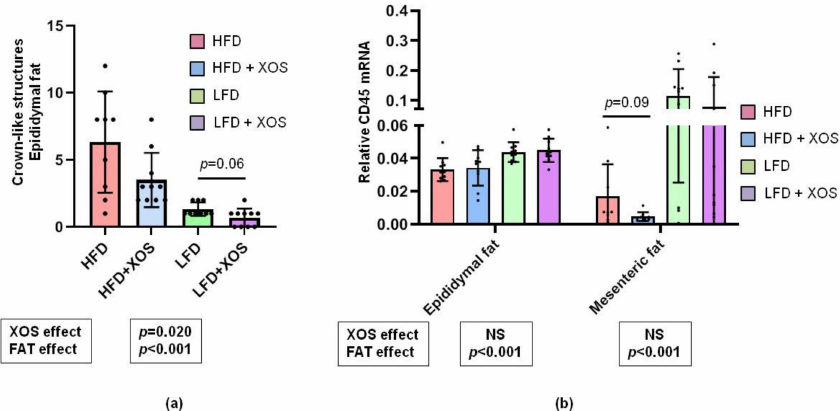
Figure 4. The effects of the diets on adipose tissue inflammation markers. ( a ) The graph shows the observed counts of CLSs in epididymal adipose tissue as determined by histopathological scoring. N = 10/group. The black dots in the bars show individual data points. ( b ) The graph shows the relative expression levels of CD45 mRNA in both epididymal and mesenteric adipose tissue that were quantified with qPCR. n = 8–10/group. The black dots in the bars show individual data points.